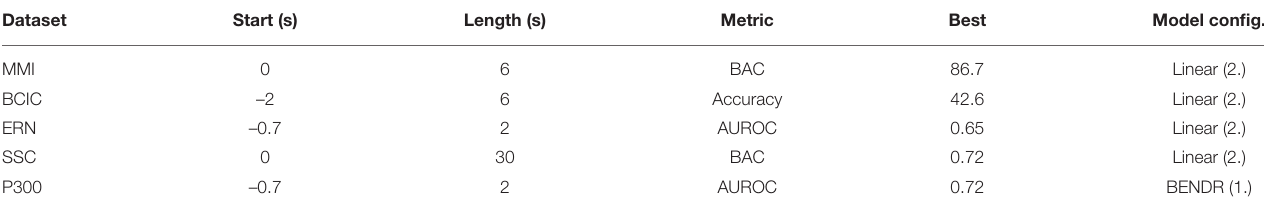
TABLE 2 | Performances of downstream datasets.